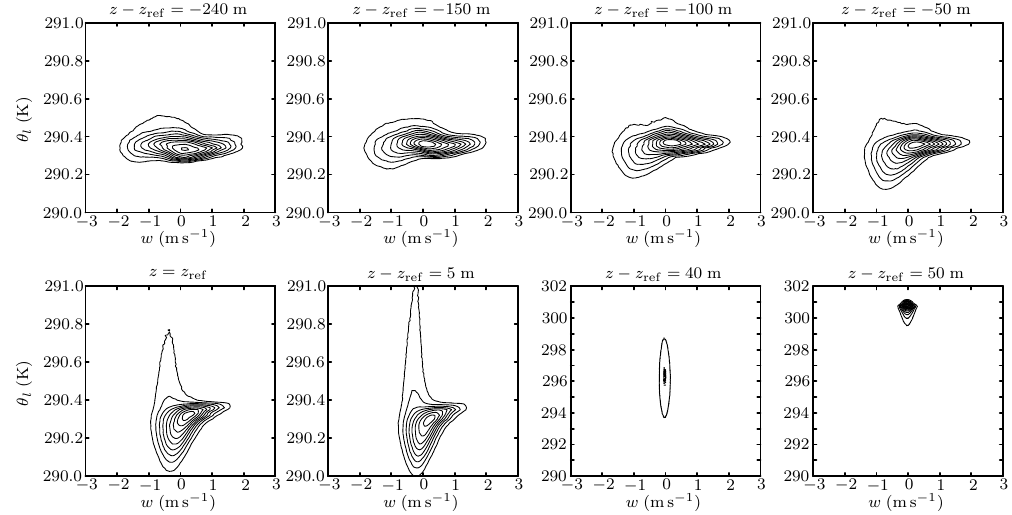
Figure 7. Joint probability density functions of liquid water potential temperature and vertical velocity. Each panel corresponds to different height. The heights are with respect to the height of the maximum mean cloud liquid z ref . The contours are plotted in logarithmic intervals.